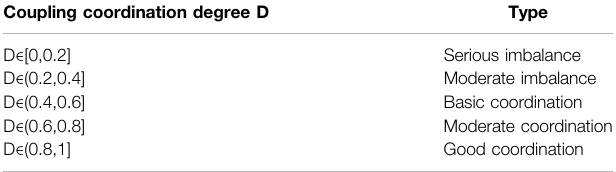
TABLE 2 | Coordination types. Coupling coordination degree D